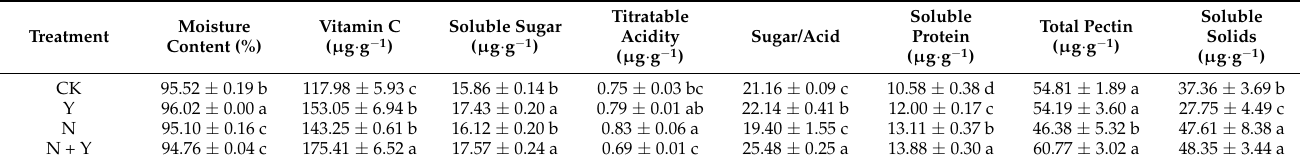
Table 2. Fruit qualities of fresh cucumbers under different